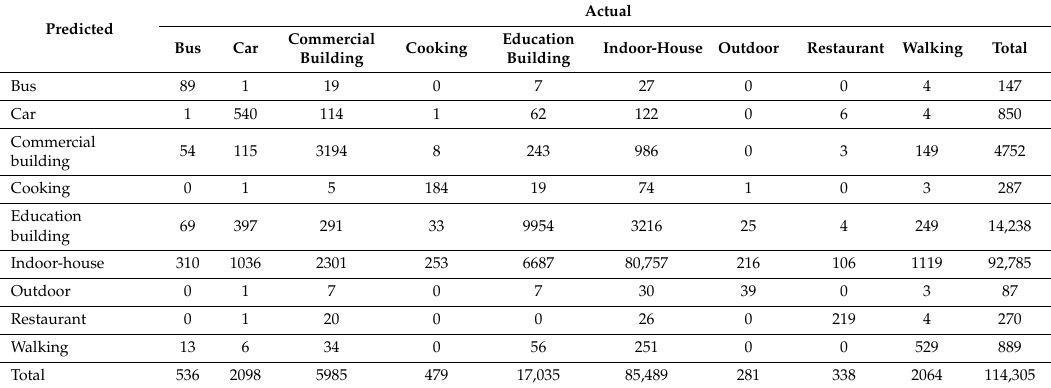
Table 2. Confusion table for training data simulation using raw dataset.